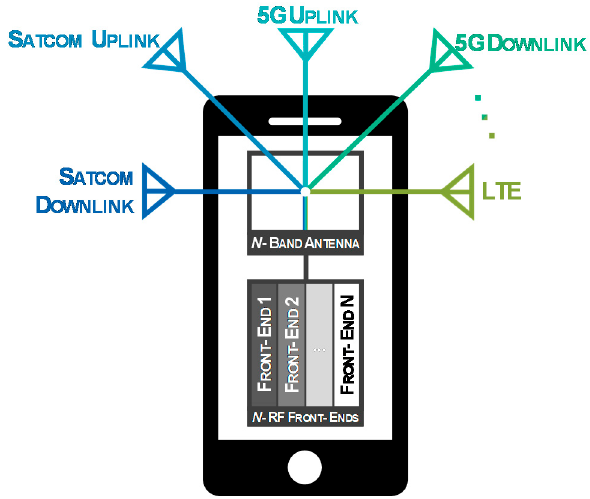
Figure 1. Single N-Band Antenna Shared by Multiple Frontends.